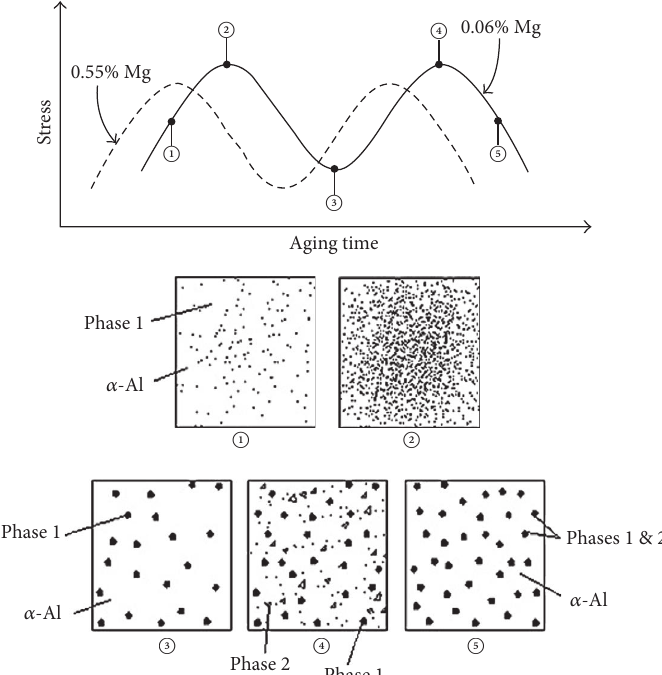
Figure 9: Schematic diagrams showing the possible precipitation, dissolution, and coarsening of the age hardening phases during the course of aging.